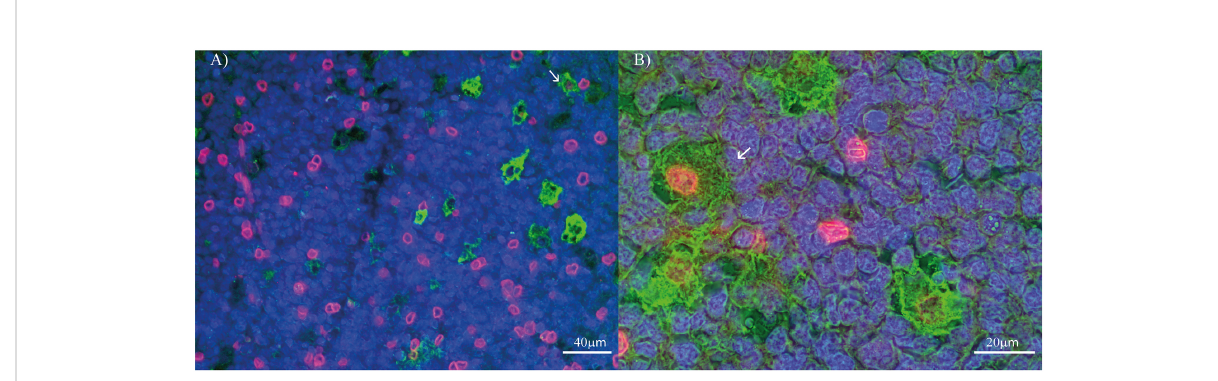
FIGURE 2 PD-L1 and macrophages ’ polarization pro fi le markers double-staining in pediatric patients ’ tonsil. (A) Double stain for PD-L1 (Red) and CD68 (Green) at 400X. (B) Double stain for PD-L1 (Red) and CD163 (Green) at 1000X. Each image includes a nuclear counterstain Hoechst